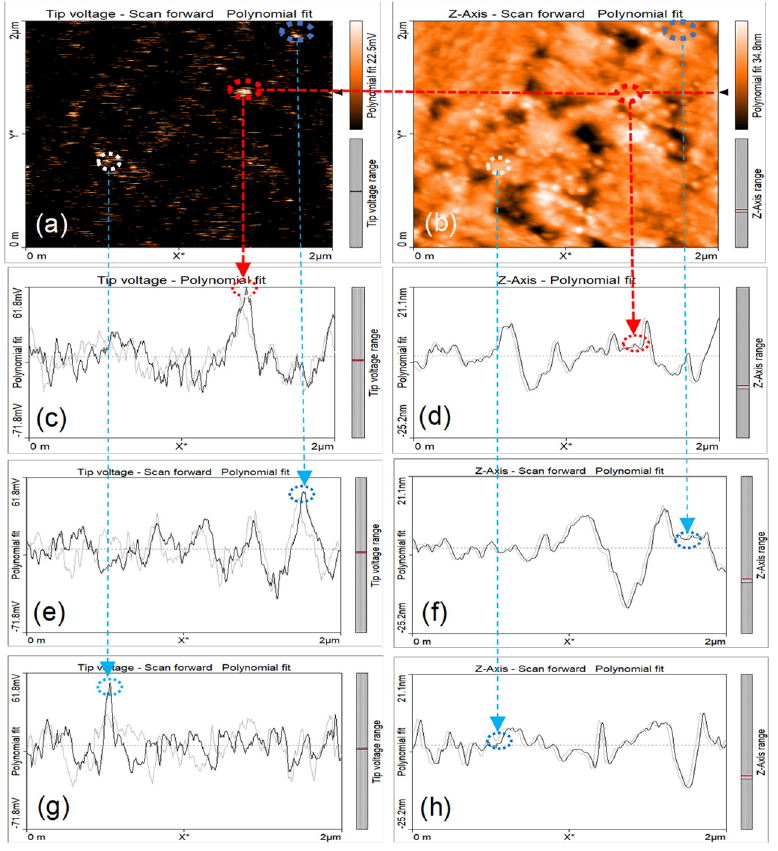
Figure 4. ( a , c , e , g ) KPFM images for sample T 2 ; ( b , d , f , h ) AFM images at the same region of sample T 2 .